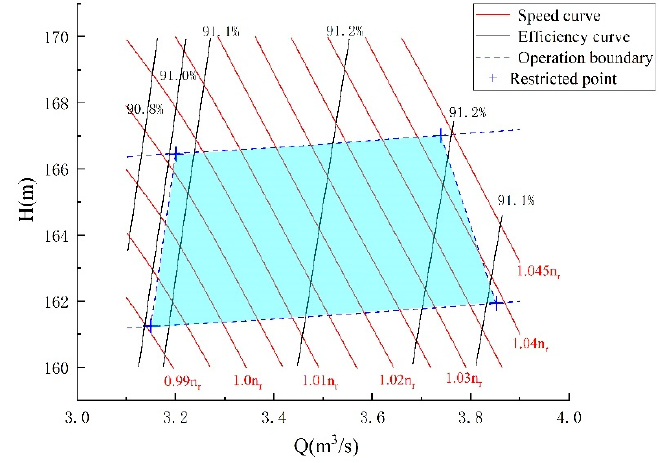
Figure 20. Regulation characteristics in the pump mode.